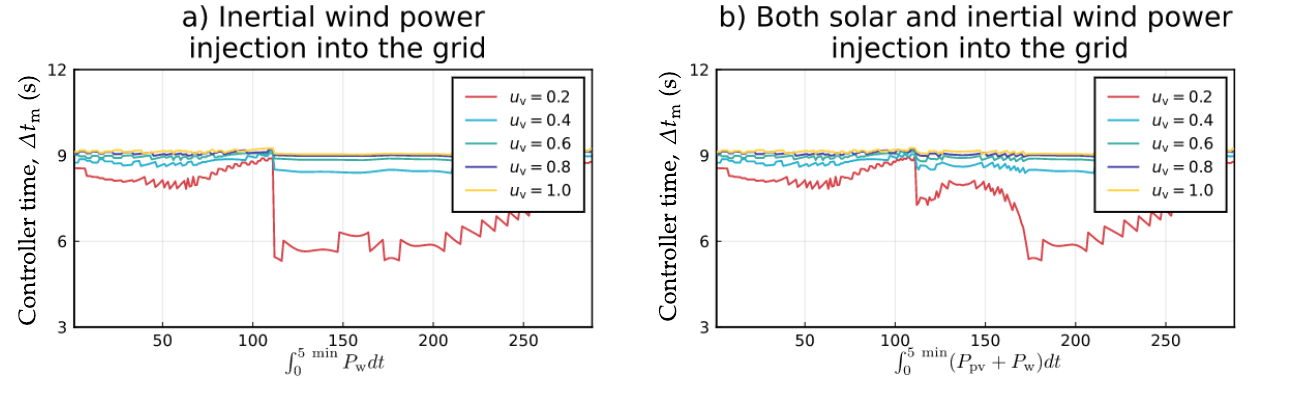
Figure 6. Inertial wind power injection into the grid. ∆ t m is the maximum controller discretization time calculated for power injected at an interval of 5